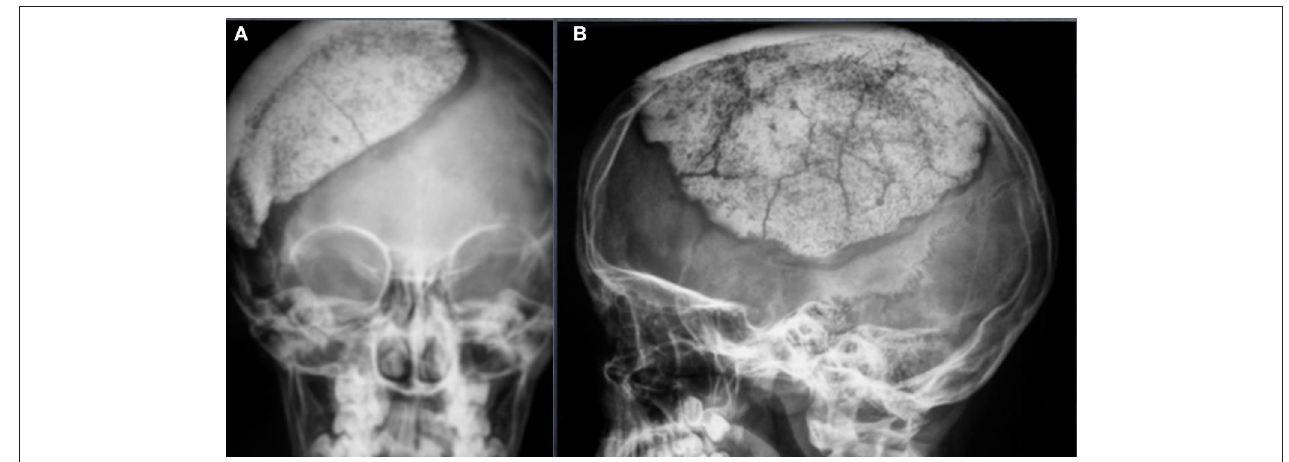
FIGURE 1 | Occipitofrontal (OF) (A) and Anteroposterior (AP) (B) view of an asymptomatic fracture of a 12 years old patient operated for a decompressive craniectomy after a traumatic brain injury. From the clinical point of view, the patient has no clinical signs of fracture. No surgical revision was needed.